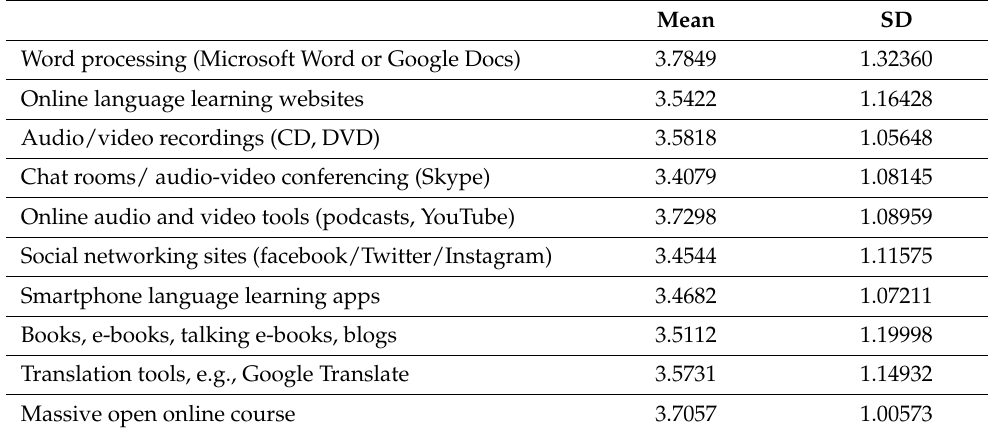
Table 4. Use pattern of different technologies for improving knowledge and skills in language learning.